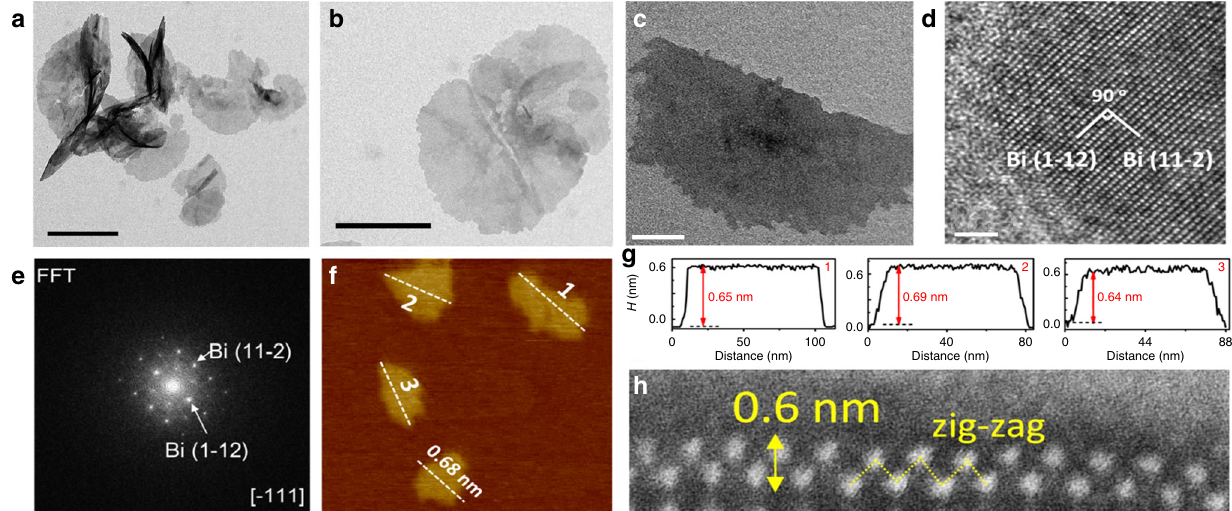
Fig. 1 Characterization of monolayer Bi nanosheets (Bismuthene). a − c Typical TEM images. Scale bar in ( a ): 500 nm; scale bar in ( b ): 200 nm; scale bar in ( c ): 50 nm. d Typical HRTEM image; scale bar: 2 nm. e FFT of ( d ). f Typical atomic force microscopy (AFM) image. g The corresponding height pro fi les for three Bismuthene nanosheets marked in ( f ). h Typical lateral HAADF-STEM image of a Bismuthene nanosheet, directly showing the single-atom thickness of the layer with zig-zag